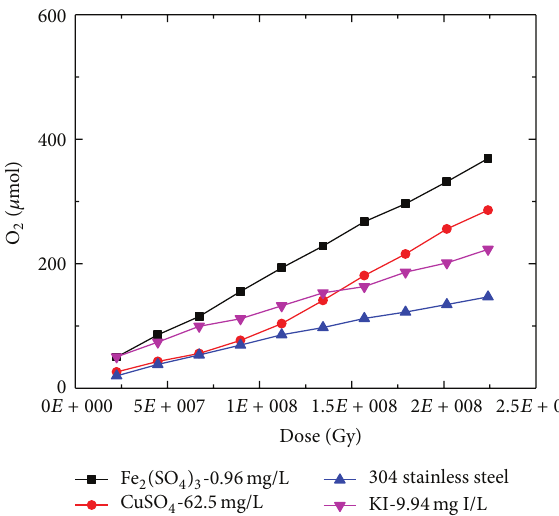
Figure 7: Hydrogen to oxygen ratios measured for UO 2 SO 4 solu- tions during irradiation tests at the Van de Graaff.